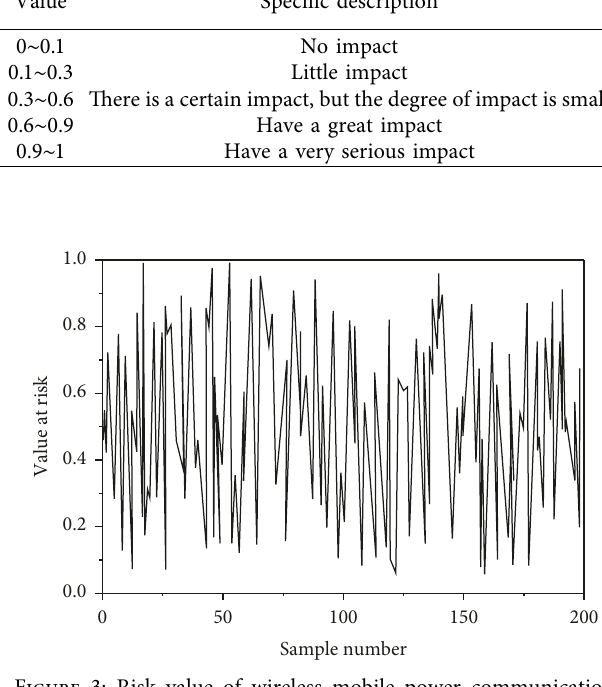
Figure 3: Risk value of wireless mobile power communication system risk assessment.